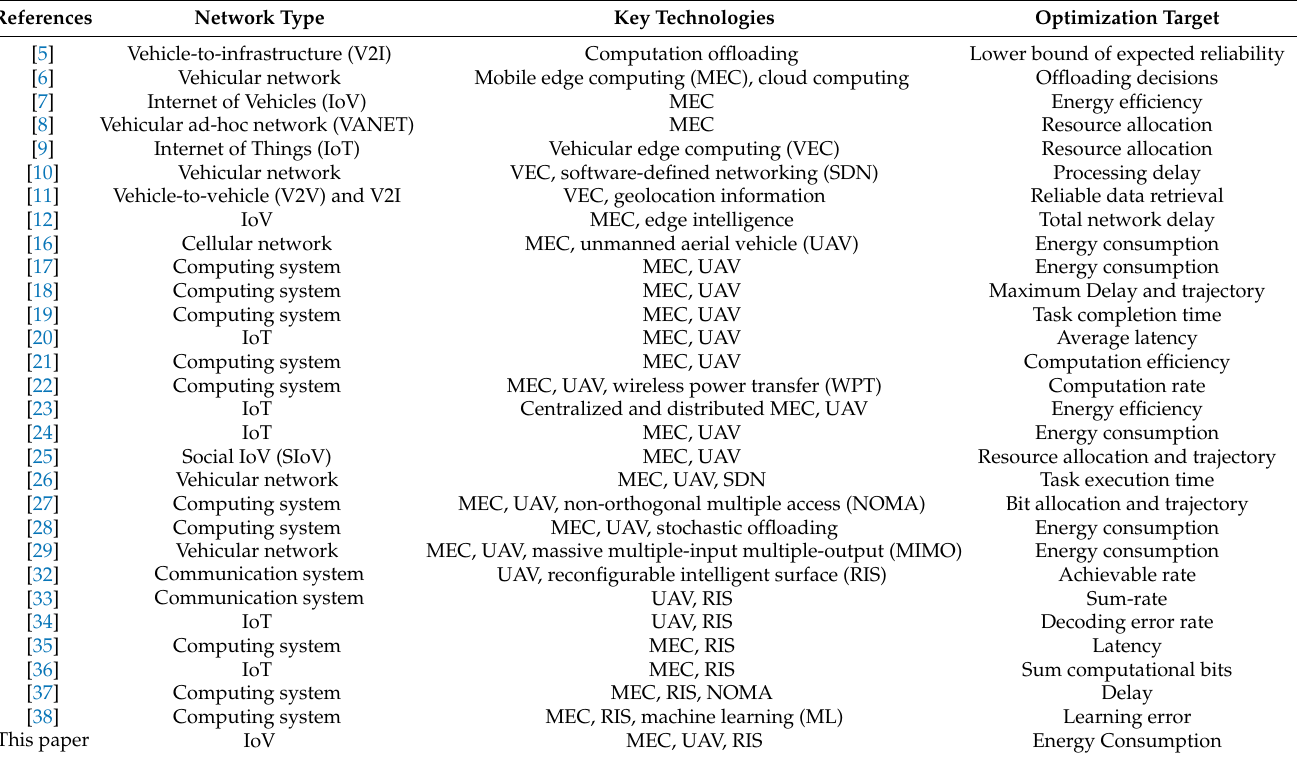
Table 1. Synopsis of relevant research